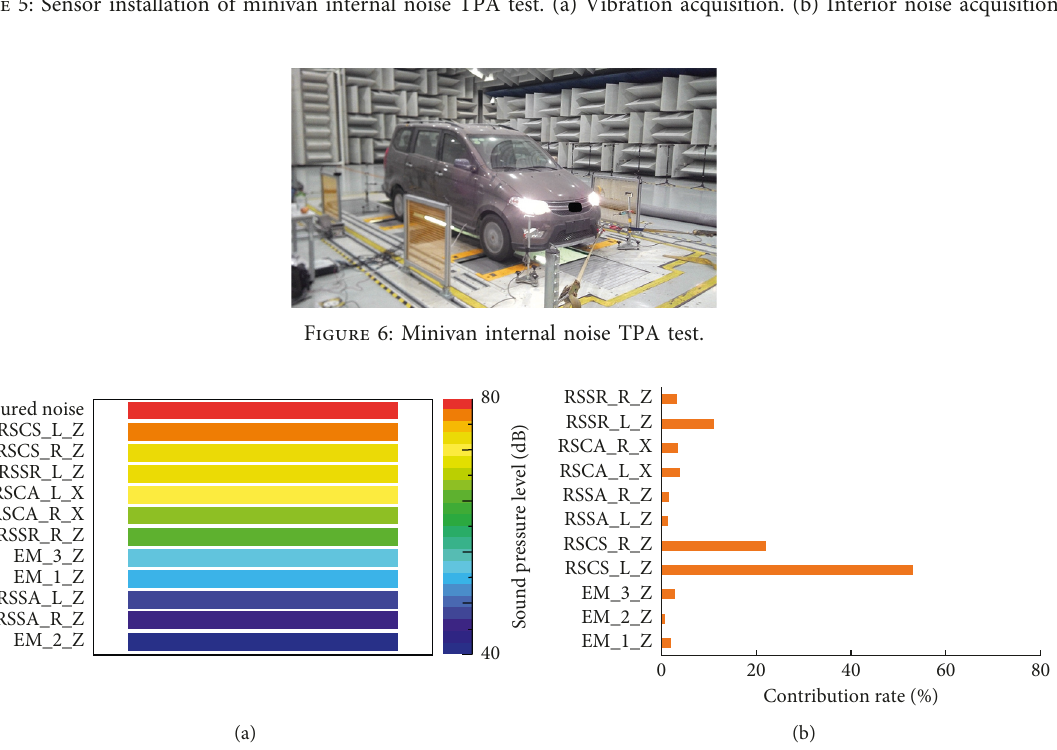
Figure 7: Contributions of different transfer paths. (a) Ranking of contributions. (b) Percentages of